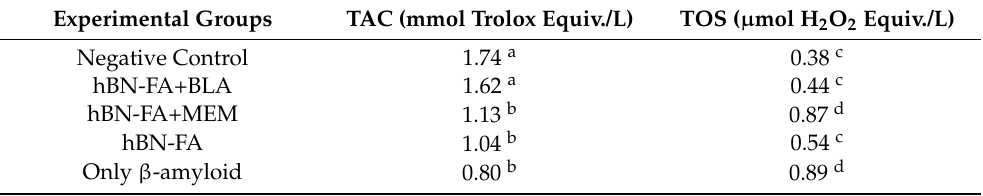
Figure 15. The effects of hBN-FA+BLA, hBN-FA+MEM, and hBN (25 µ g/mL) applications on A β 1-42-induced AChE activity. (Each superscript letter ( a, b, c ) represents statistically similar groups). Table 4. TAC and TOS values in experimental AD model against hBN-FA+BLA, hBN-FA+MEM and hBN (25 µ g/mL) applications for 24 h. (Each superscript letter ( a, b, c, d ) represents statistically similar groups).